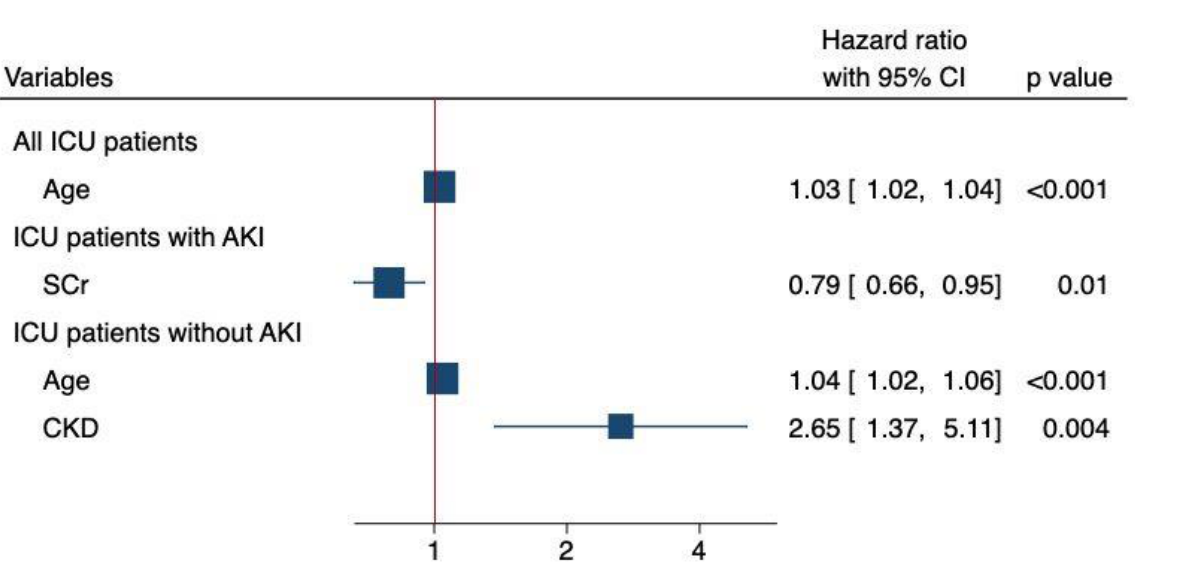
Figure 3. Forest plot depicting the impact of the indicated risk factors on the hazard ratio (HR) for mortality as determined by Cox proportional hazards with stepwise forward variable selection. For continuous variables, the hazard ratio (HR) represents the relative amount by which the probability of obtaining the outcome increases or decreases when the independent variable is changed by exactly one unit.